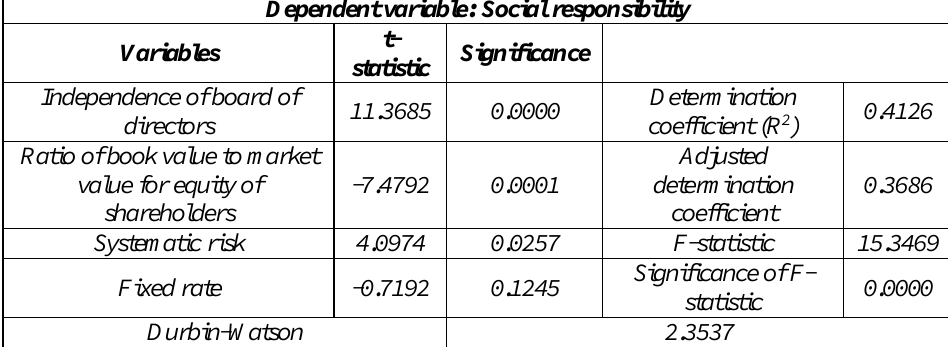
Table 7. The findings of approximation of regressive model related to the